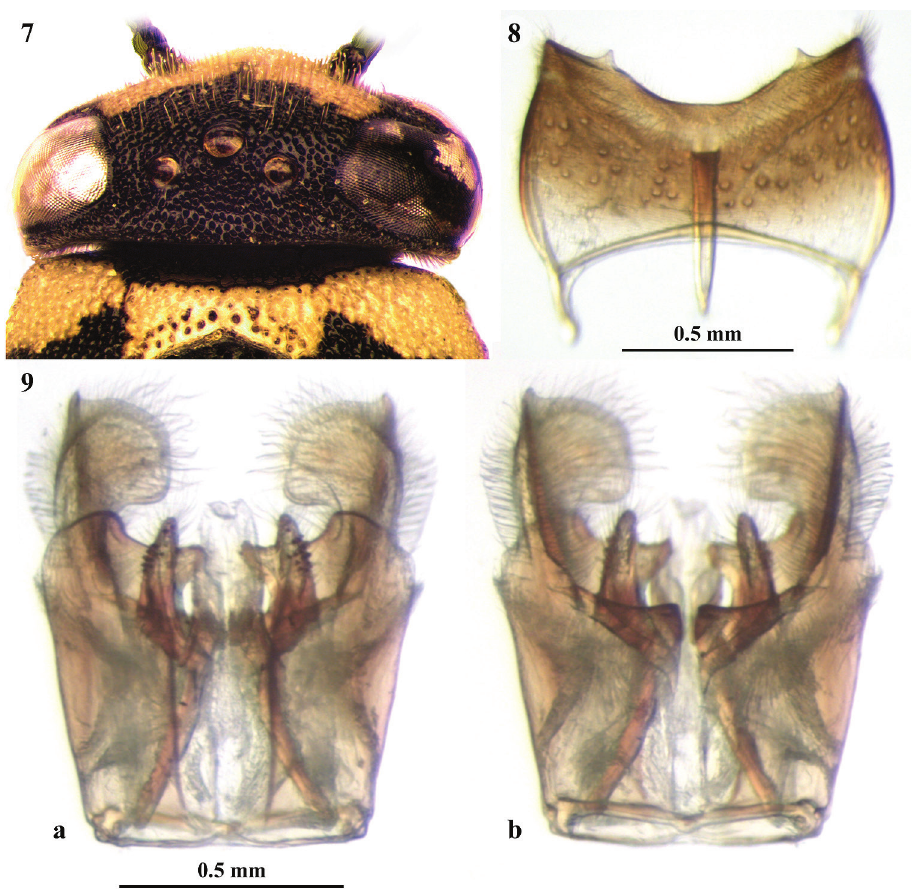
Figures 7–9. Head of male Celonites hermon in dorsal view (dbM No. 3456) 8 Metasomal sternum VIII of male of C. hermon in ventral view (dbM No. 3689) 9 Male genital of Celonites hermon (dbM No. 3689) a in dorsal b ventral view.